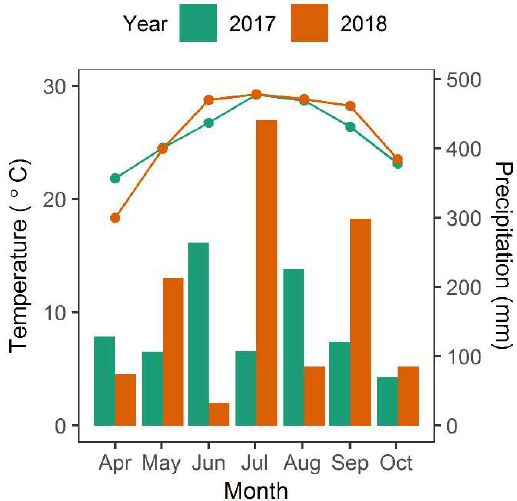
Figure 8. Average monthly temperature ( ◦ C) and cumulative monthly precipitation during the growing season within North Inlet for 2017 and 2018. The bar graph indicates precipitation and line graph indicates temperature. Data are from a weather station at North Inlet.